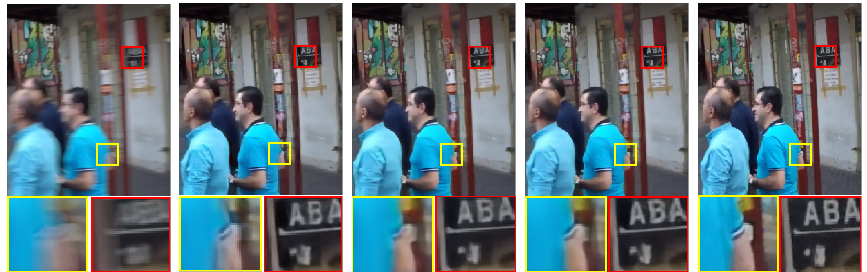
Figure 3. Subjective results of ablation experiments. From left to right are the blurry image, restoration results of the Local-Branch-Net (LB-Net), Dual-Branches-Net (DB-Net), Dual-Branch Attention Fusion Net (DBAF-Net), and the ground